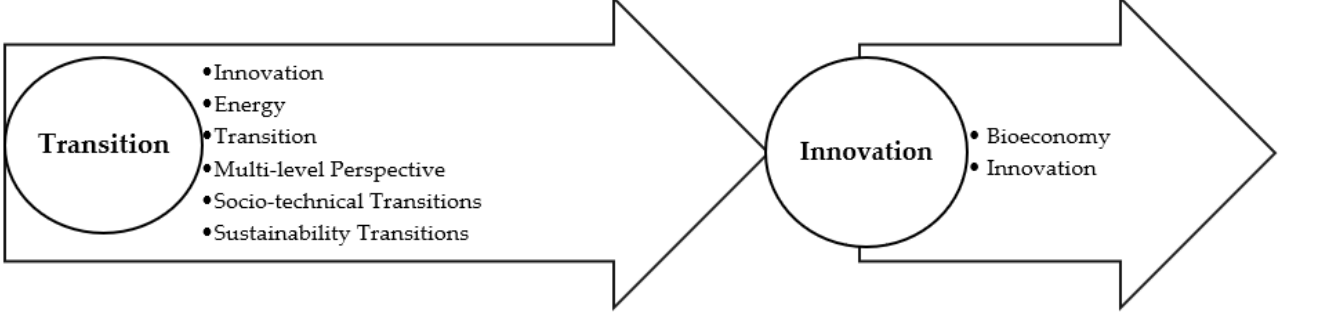
Figure 16. Main topics of Transition–Innovation Clusters.